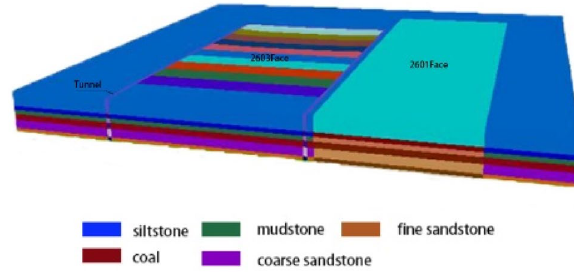
Figure 5. FLAC3D numerical model.